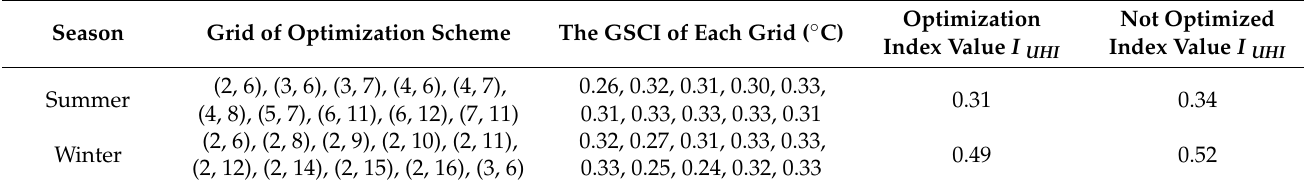
Table 4. Optimization simulation